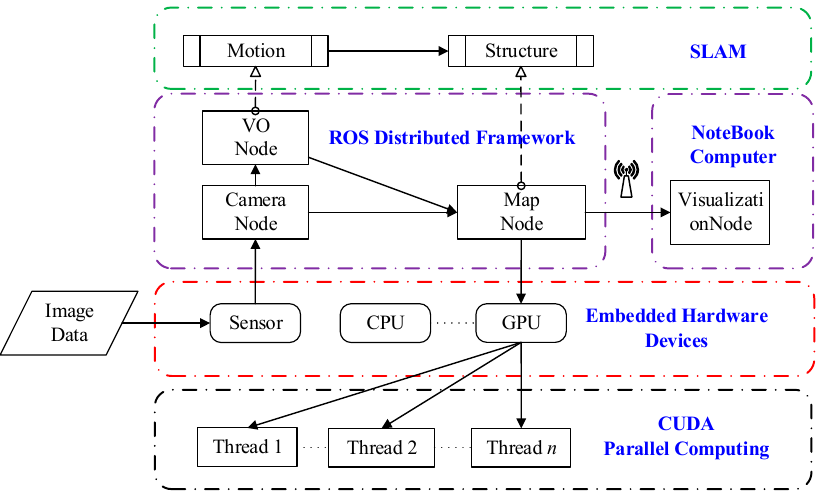
Figure 2. The framework of the graphics processing unit (GPU)-enabled unmanned aerial vehicle (UAV) platform.